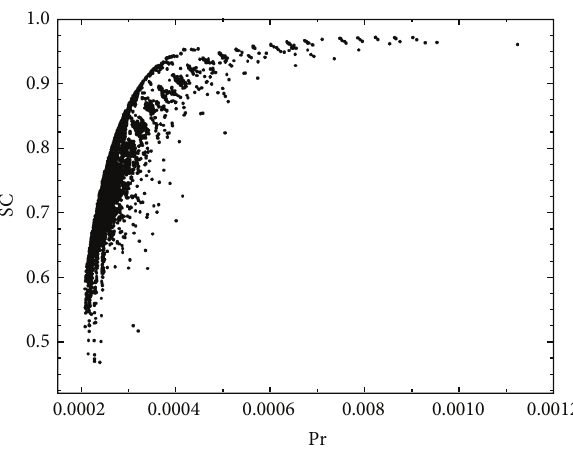
Figure 1: Dependence of SC on